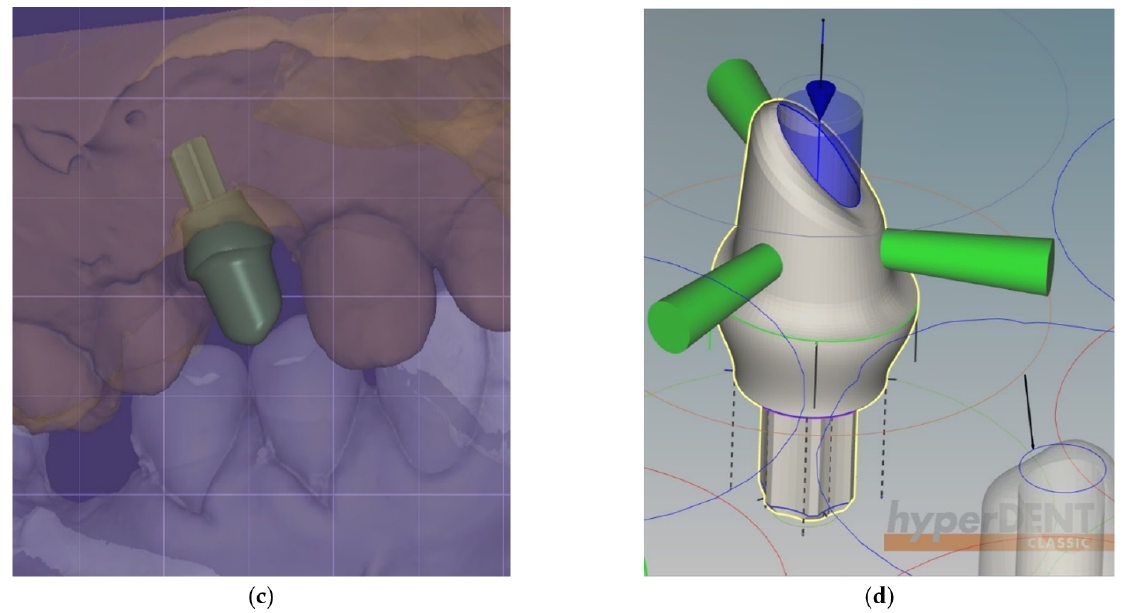
Figure 4. ( a ) Scanning of the scanning abutment to allow the virtual transfer of the implant position, taking the information from the scanning software and loading it into the Exocad design software; ( b ) the design of the prosthetic abutment; ( c ) prosthetic abutment with connection ; ( d ) loading in the hyperDENT Classic software and computing the milling